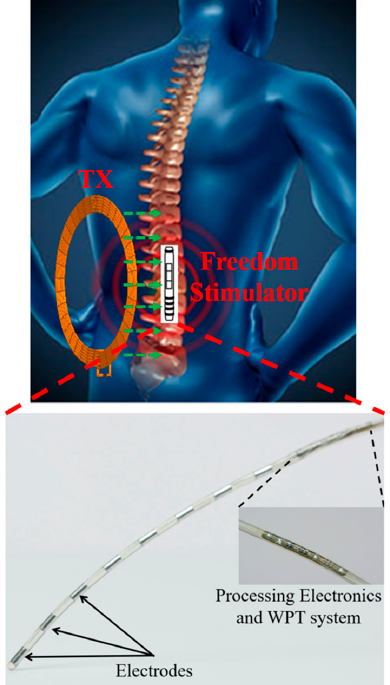
Figure 13. Spinal cord stimulator for StimWave.